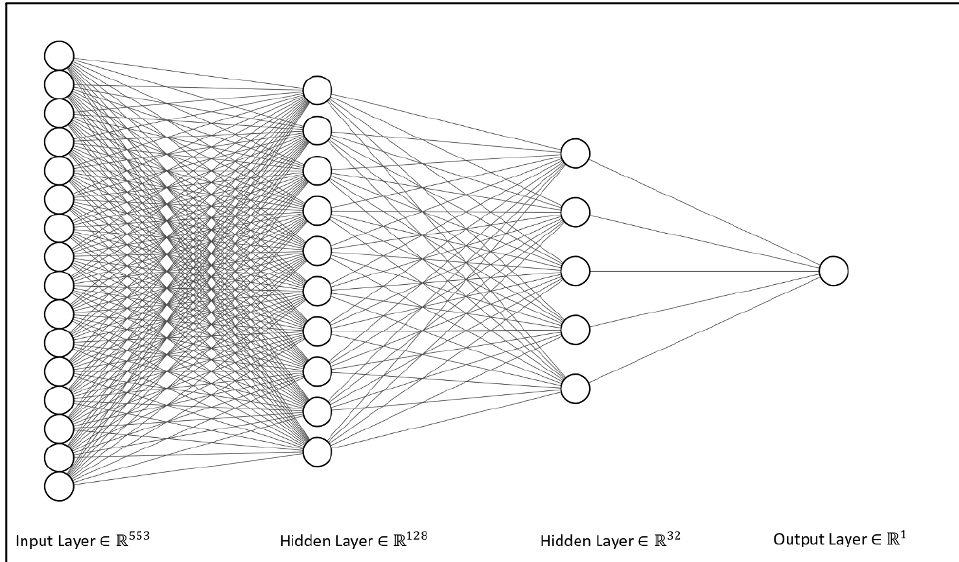
Figure 6. The proposed NN